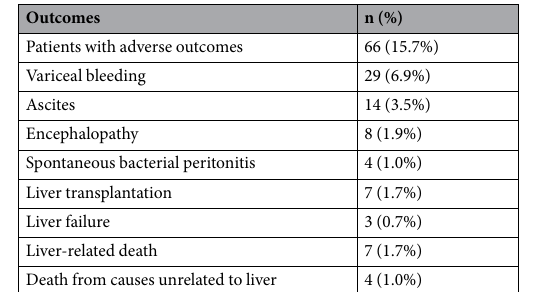
Table 3. Newly occurring complications during follow-up in the PBC cohort (n = 420).